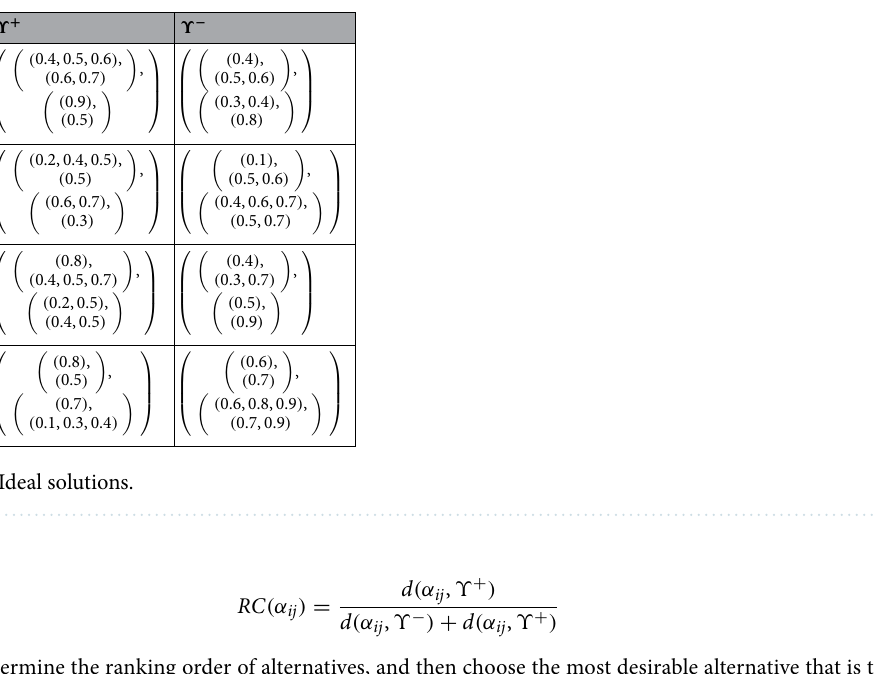
Table 16 computes both positive and negative ideal solutions as follows: